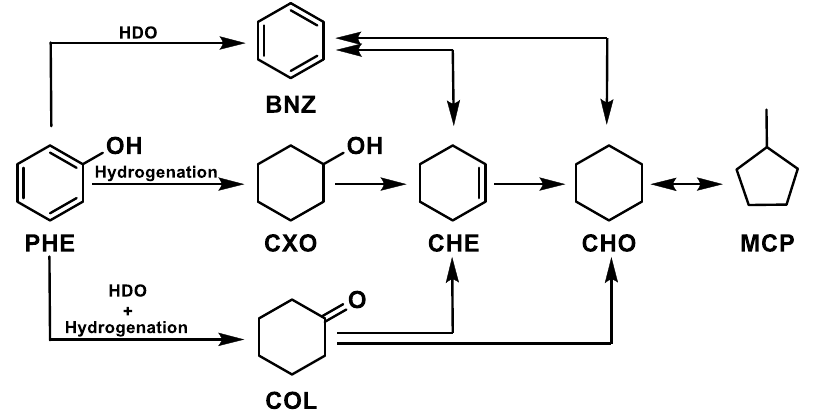
Figure 4. Phenol hydrogenation pathways.